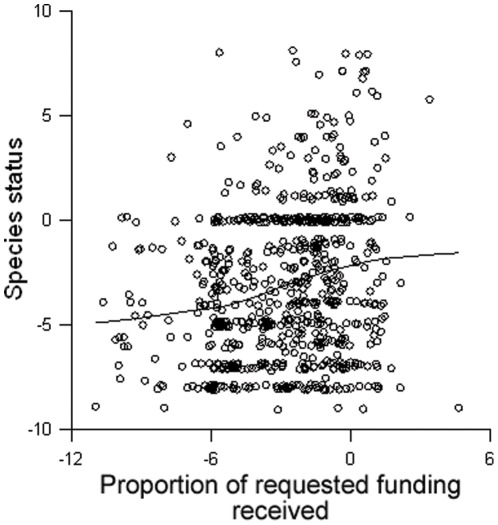
Relationship between population status and funding.Scatter plot of species population status score and the proportion of funding requested in species recovery plan that has been received. Proportion of funding received is natural logarithm transformed. Line shows LOWESS smoothing function with tension = 0.7. N = 752.